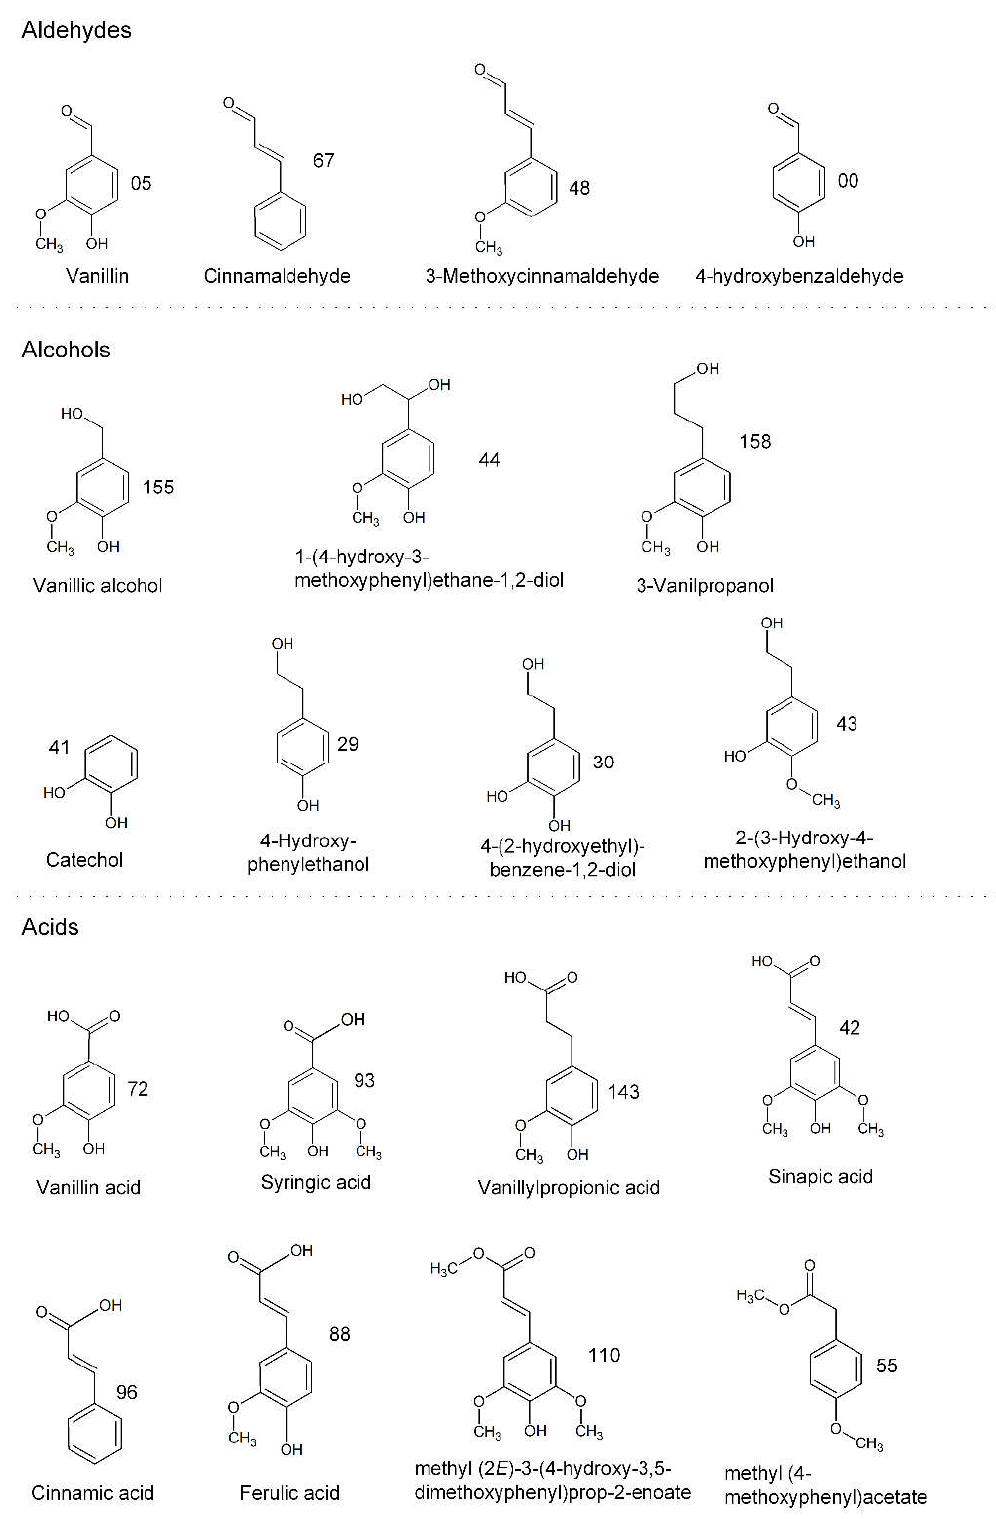
Figure 3. Phenolic compounds found in fed-batch cultivation with spruce hydrolysate. Numbers represent the percentage ratio at the end of fed-batch cultivation between the amount of compound measured and the amount of compound added to the medium. Values above 100 indicate that the compound was produced during the cultivation while values below 100 indicate compound conversion. The amount of each phenolic compound added during the fed-batch cultivation was calculated based on the initial concentration of the compound in the spruce